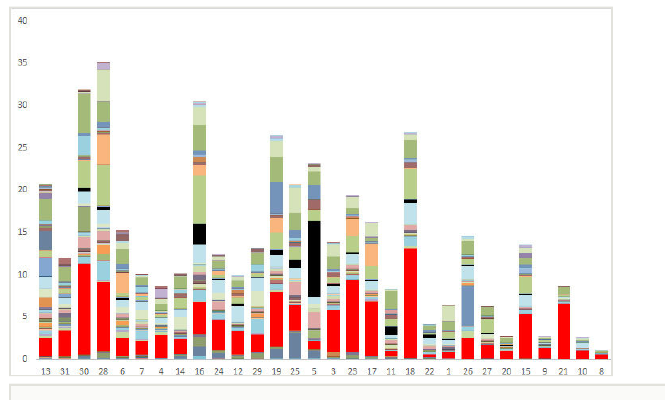
Figure 7. Stacked bar chart of phorid fl y catch from one year of sampling at each of 30 sites from BioSCAN project. Each color represents a di ff erent species, each bar represents a single site. Black - Megaselia marquezi Hartop et al.; red - Megaselia agarici (Lintner). Vertical axis- number of speciemens; horizontal axis- trapping sites (see Brown and Hartop 2016).